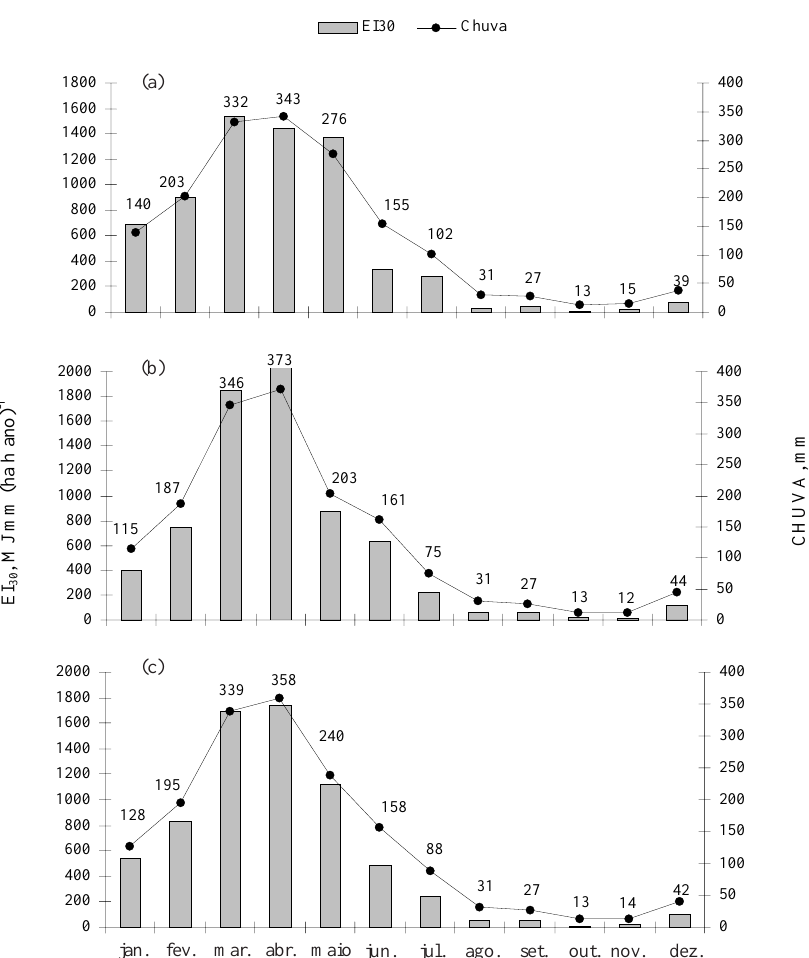
Figura 2. Distribuição dos valores médios do índice EI 1962 a 1981 (a), de 1982 a 2000 (b) e 1962 a 2000 (c).